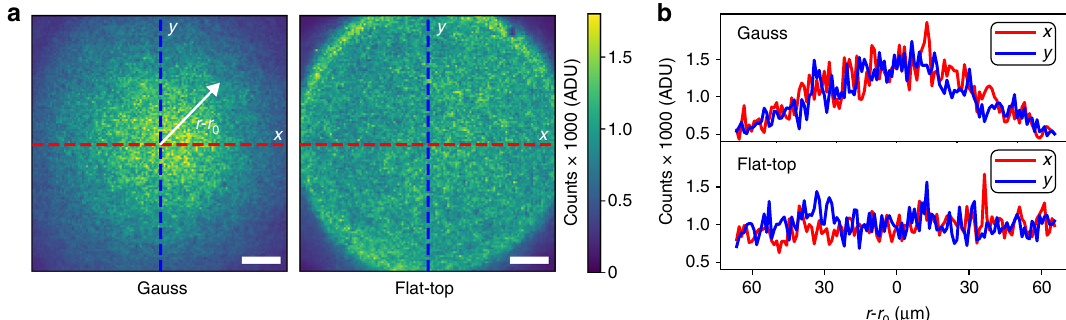
Fig. 1 Gauss vs. fl at-top illumination pro fi les. a Traditional illumination pro fi le for TIRF microscopy with a Gaussian laser beam (left) compared to a fl at-top pro fi le created by a refractive beam-shaping device in the excitation path (right). b Line plots of fl uorescence intensity along x and y axes (red and blue, respectively) for both pro fi les in a . Scale bars, 20 µ m in a